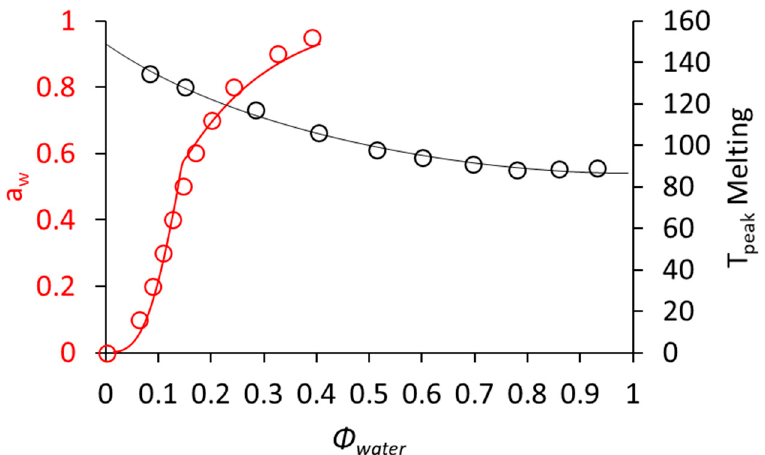
Figure 3. Peak temperature of CPPC denaturation (black circles) and moisture sorption behavior of CPPC (red circles) as a function of Φ water as described by the FH model (Equation (1)) and the FHFV model (Equation (2)), respectively. From the FHFV model, the T peak of CPPC after equilibration at a specific a w can be predicted using the FH model.